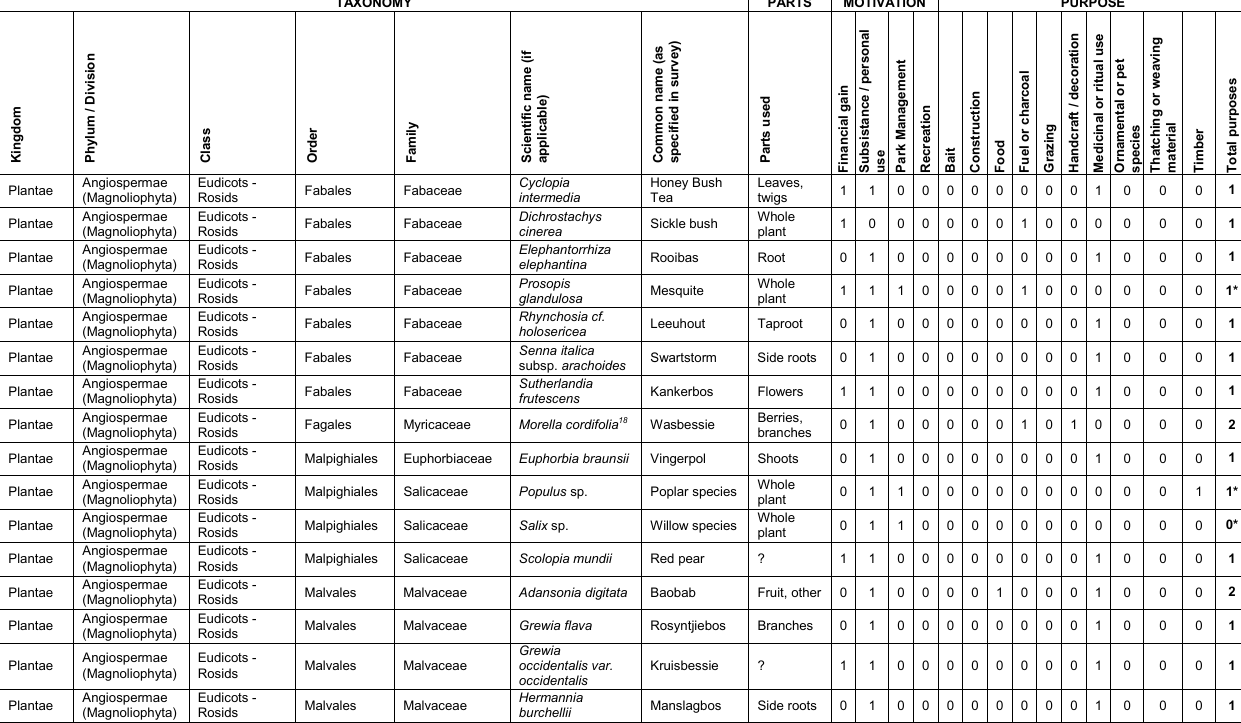
Plantae Angiospermae (Magnoliophyta) Eudicots - Rosids Scolopia mundii Plantae Angiospermae (Magnoliophyta) Eudicots - Rosids Rosyntjiebos Plantae Angiospermae (Magnoliophyta) Eudicots - Rosids Malvales Malvaceae Hermannia